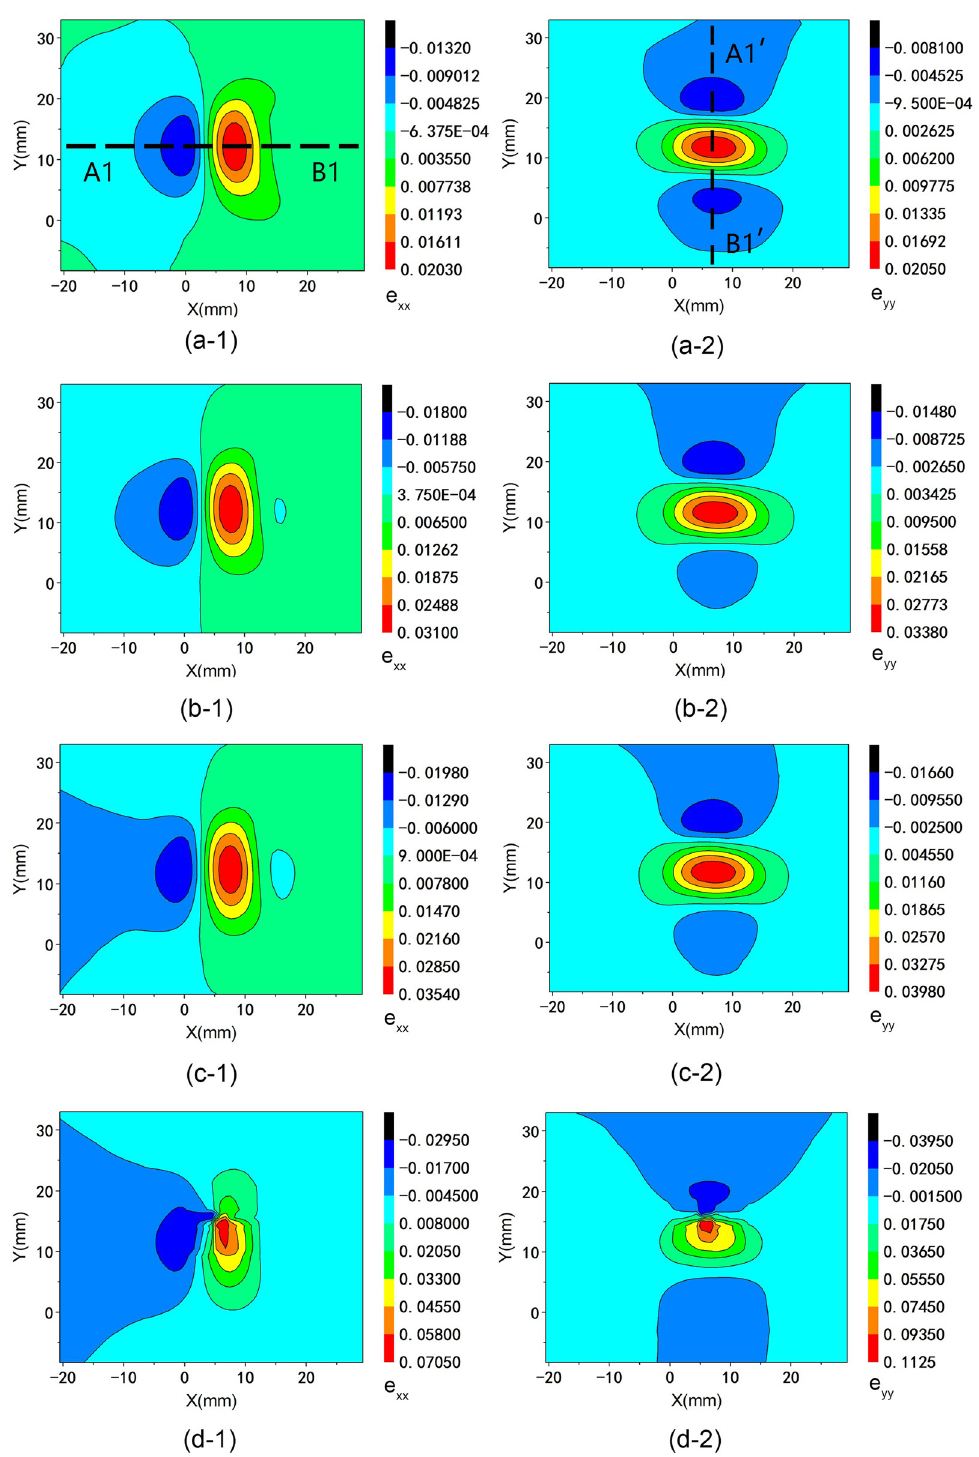
Figure 13: Strain distributions of rear face - sheet: ( a - 1 ) to ( d - 1 ) normal strain in x direction, ( a - 2 ) to ( d - 2 ) normal strain in y